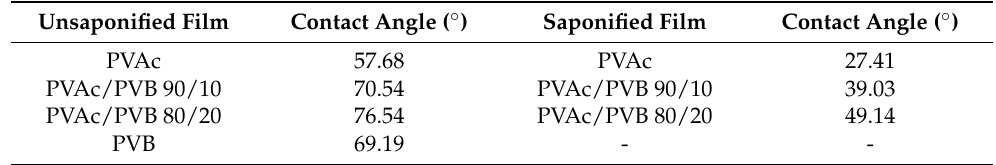
Table 5. WCA of saponified and unsaponified film samples. Unsaponified Film Contact Angle ( ◦